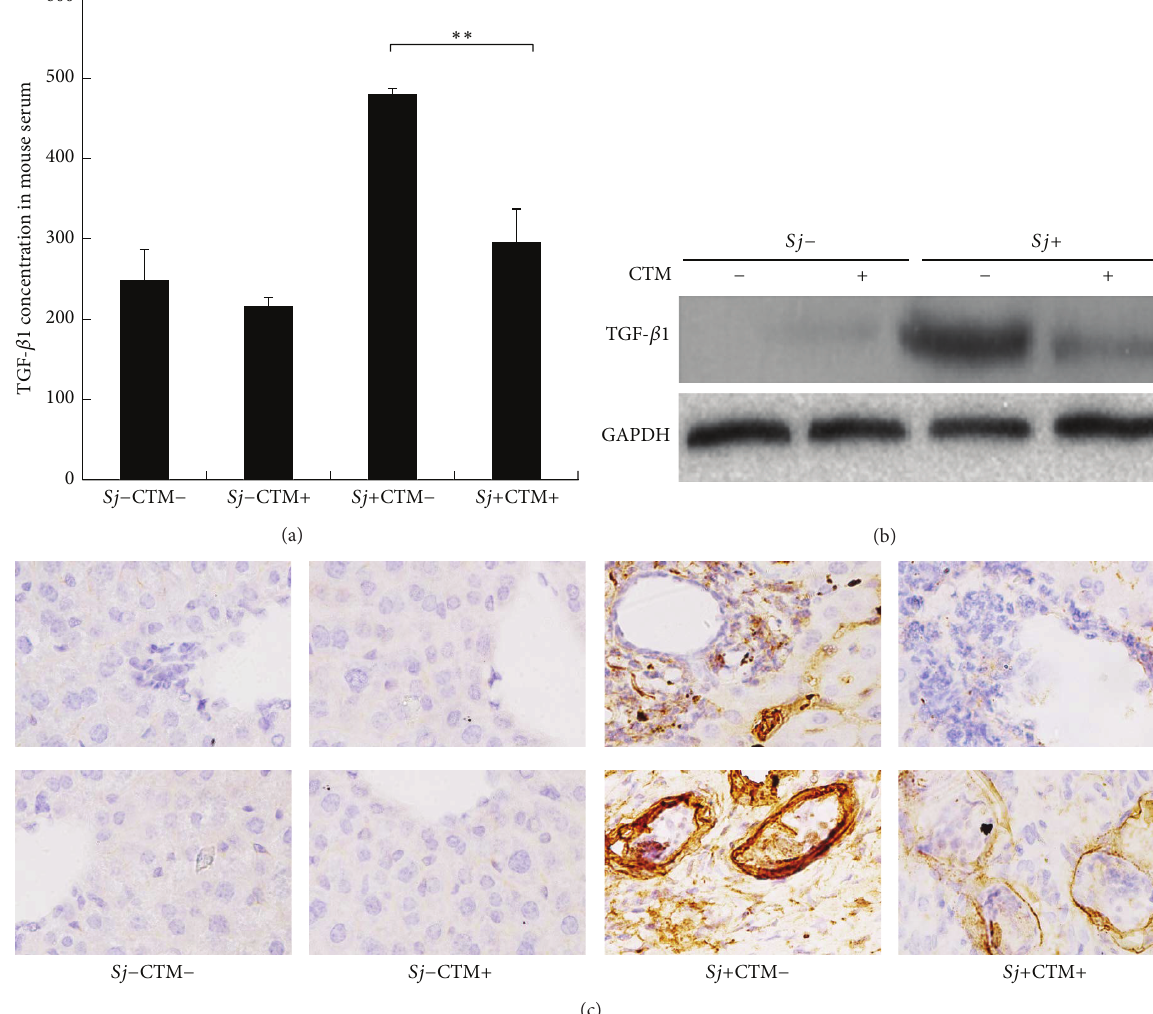
Figure 2: CTM reduced TGF- 𝛽 1 expression profile in the liver of Sj -infected mice. tTG activity of BABL/c mouse liver was inhibited by CTM intraperitoneal injection from day 3 to day 10 after Sj infection. Mice were sacrificed at week 8 after infection. (a) Activated TGF- 𝛽 1 concentration in mouse serum of normal or Sj- infected mice with or without CTM treatment was detected using ELISA. Data were presented as mean ± SD from 10 mice per each group. ∗ 𝑃 < 0.05 ; and ∗∗ 𝑃 < 0.01 . (b) Activated TGF- 𝛽 1 protein levels in mouse liver of normal or Sj - infected mice with or without CTM treatment were detected by Western blot analysis, and GAPDH was used as the internal control. (c) Mouse liver samples collected at indicated time points were fixed in paraformaldehyde, embedded in paraffin, sliced, and immunohistochemically stained for TGF- 𝛽 1. Representative stainings for TGF- 𝛽 1 were shown at 40x magnification. Bottom: TGF- 𝛽 1 expression in egg, Sj egg granuloma, and the surrounding tissue. Top: TGF- 𝛽 1 expression in hepatic cell and liver tissue around the liver sinusoid; “ − ” = without, “+” =